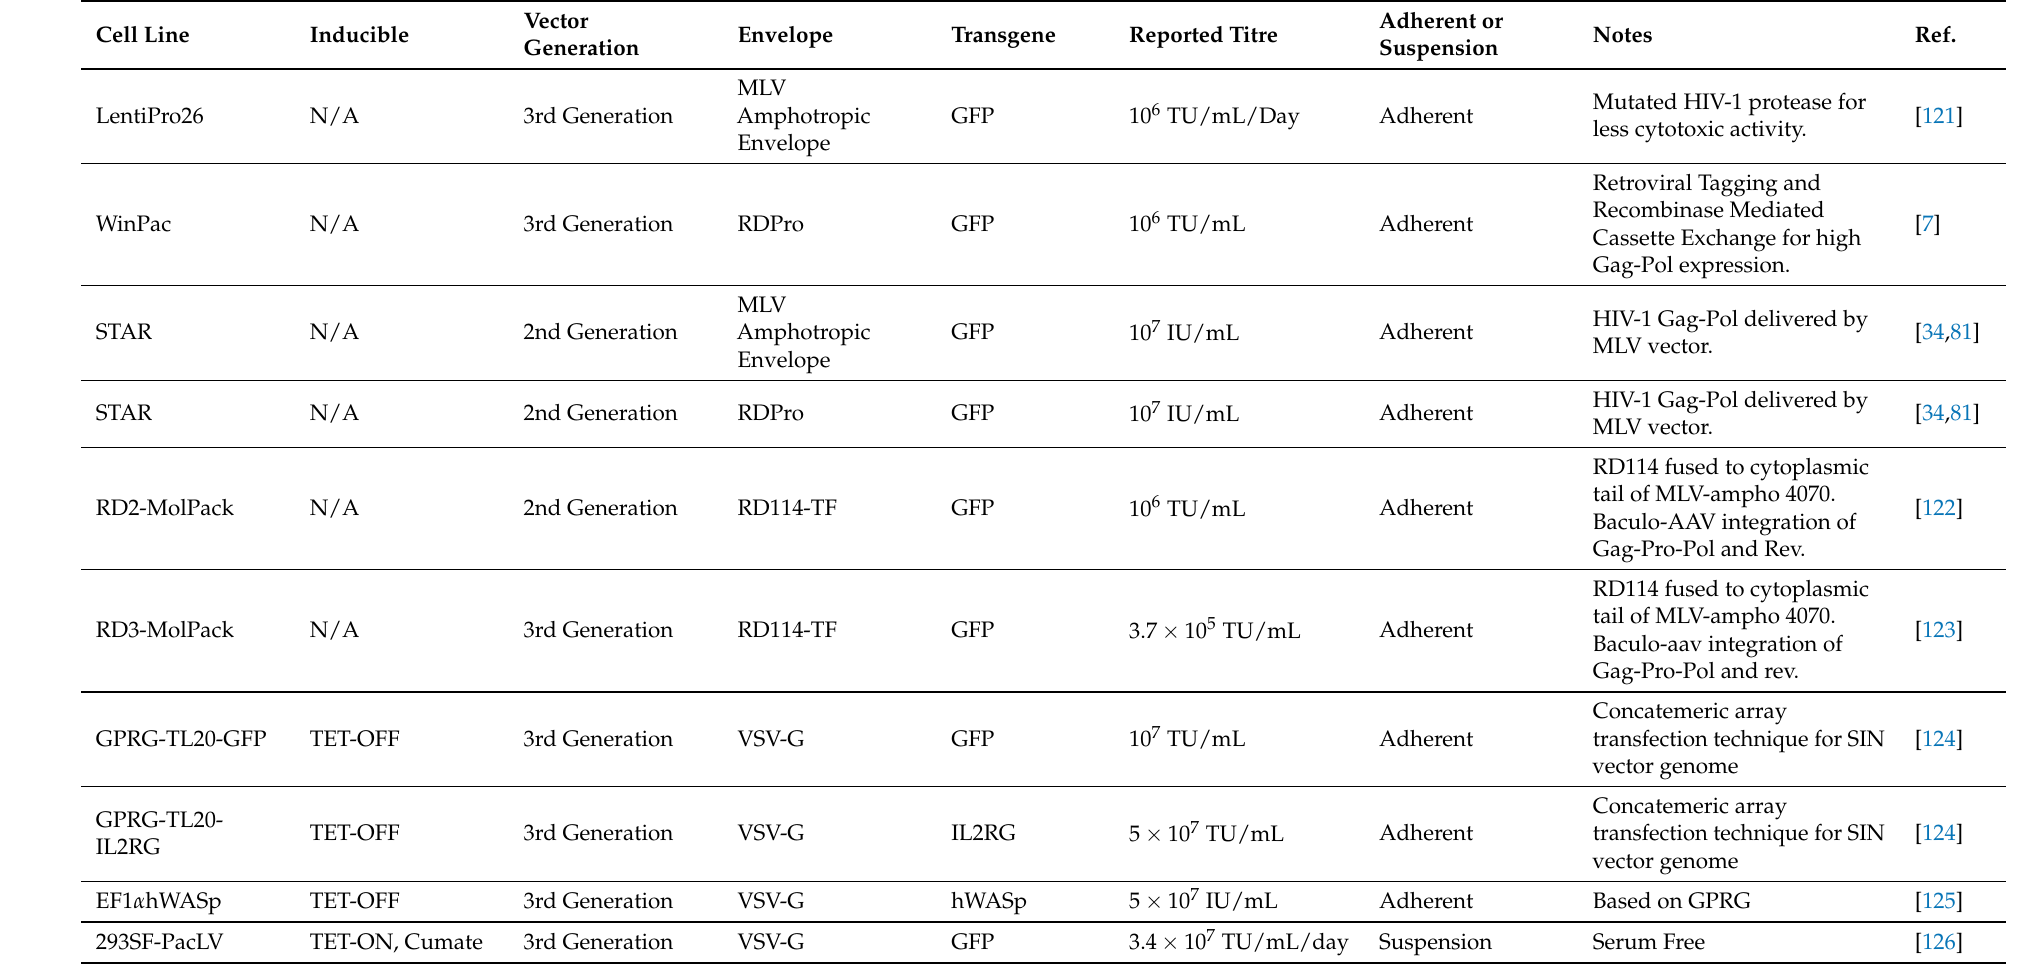
Table 3. Stable and inducible cell lines for Lentiviral vector